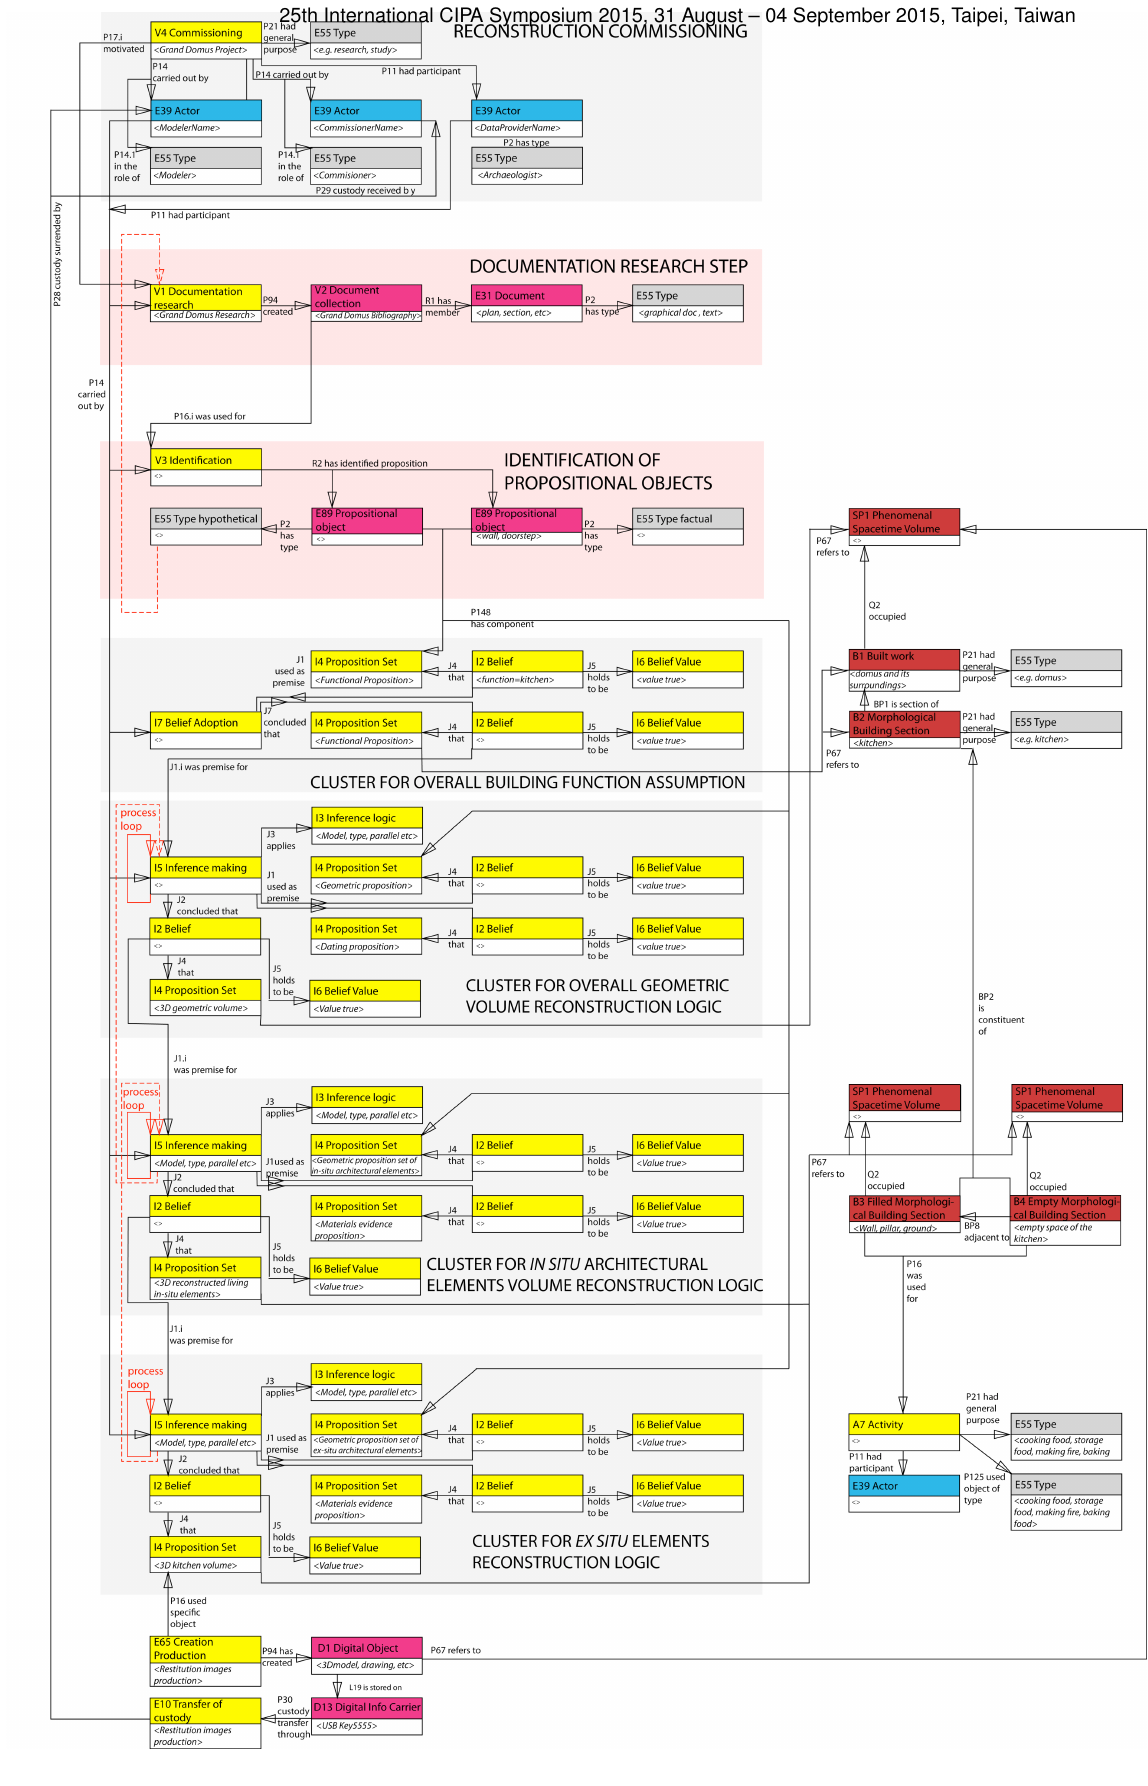
Figure 1. Graphical presentation of the virtual reconstruction process and argumentation